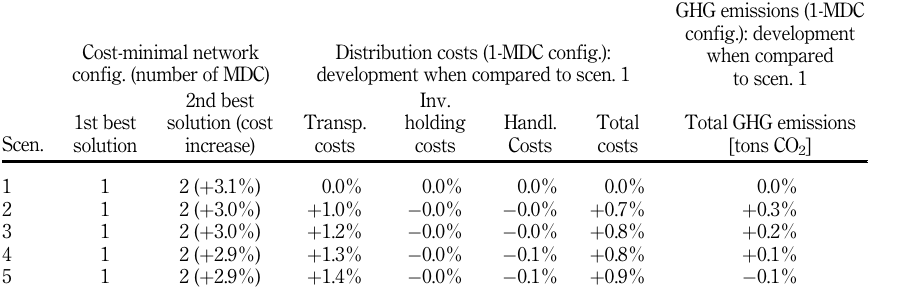
Table IV. Summary of